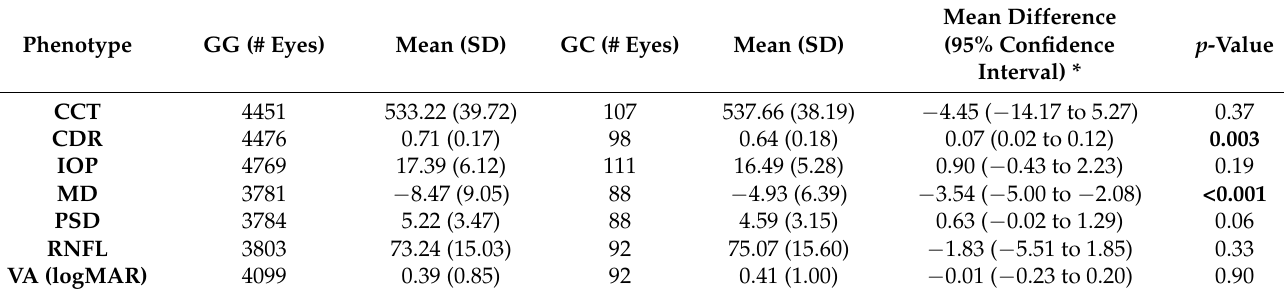
Table 3. Clinical phenotypes by LMX1B SNP rs187699205 among